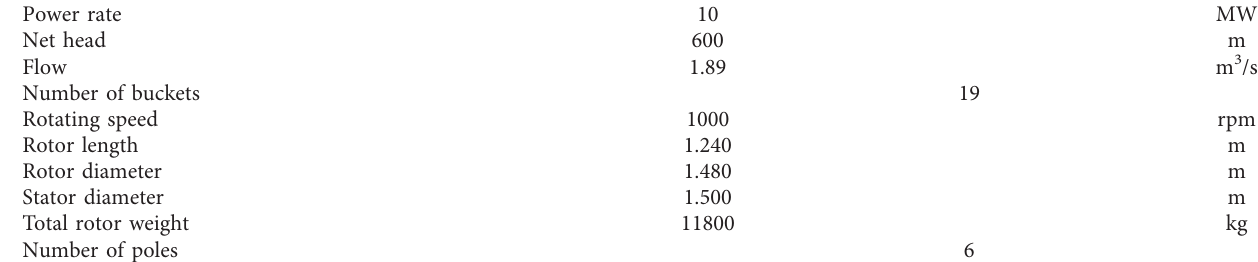
Table 1: Horizontal Pelton turbine, Case I.